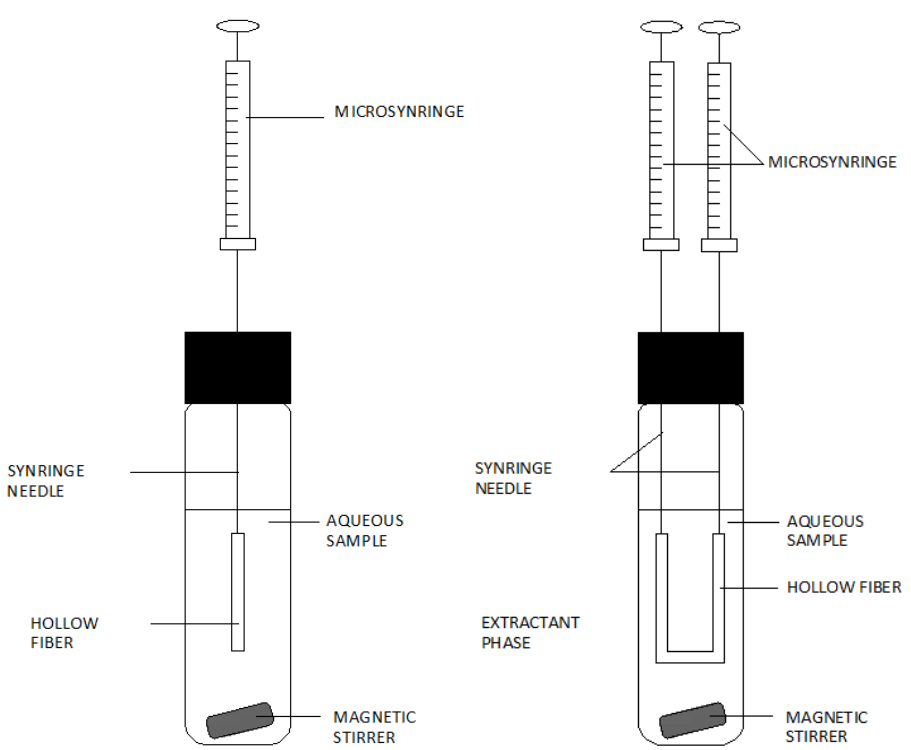
Figure 7. A diagram of the structure of a set for hollow-fibre liquid phase microextraction (HF-LPME). Based on Pena-Pereira, F. et al .